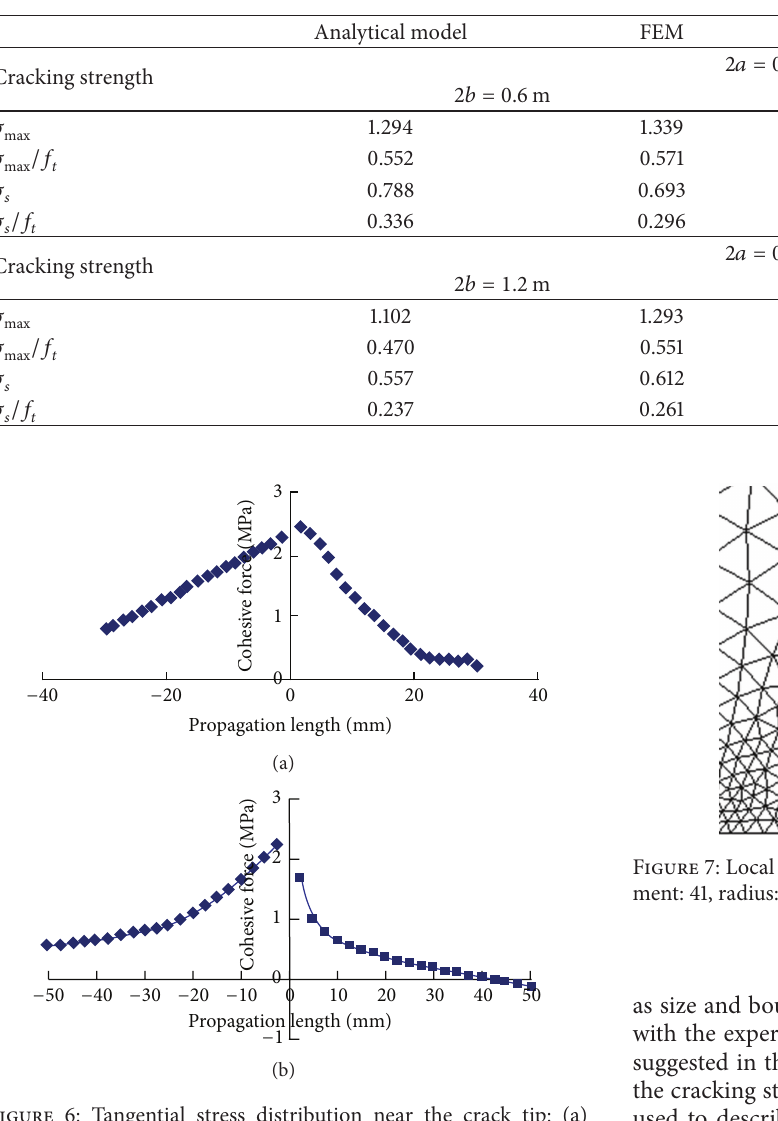
Table 3: Cracking strength for AIJs in mass concrete.